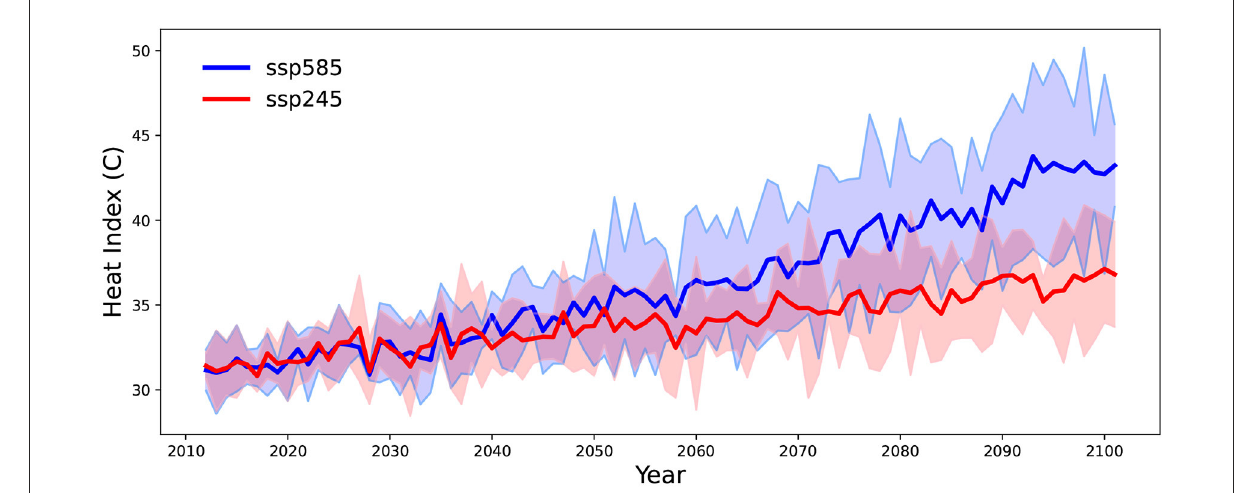
FIGURE4 Evolution of heat index over the 2015–2100 period for the ssp585 and ssp245 scenarios. The thick line shows the ensemble mean, whereas the shaded area illustrates the uncertainty estimate ( ± std).